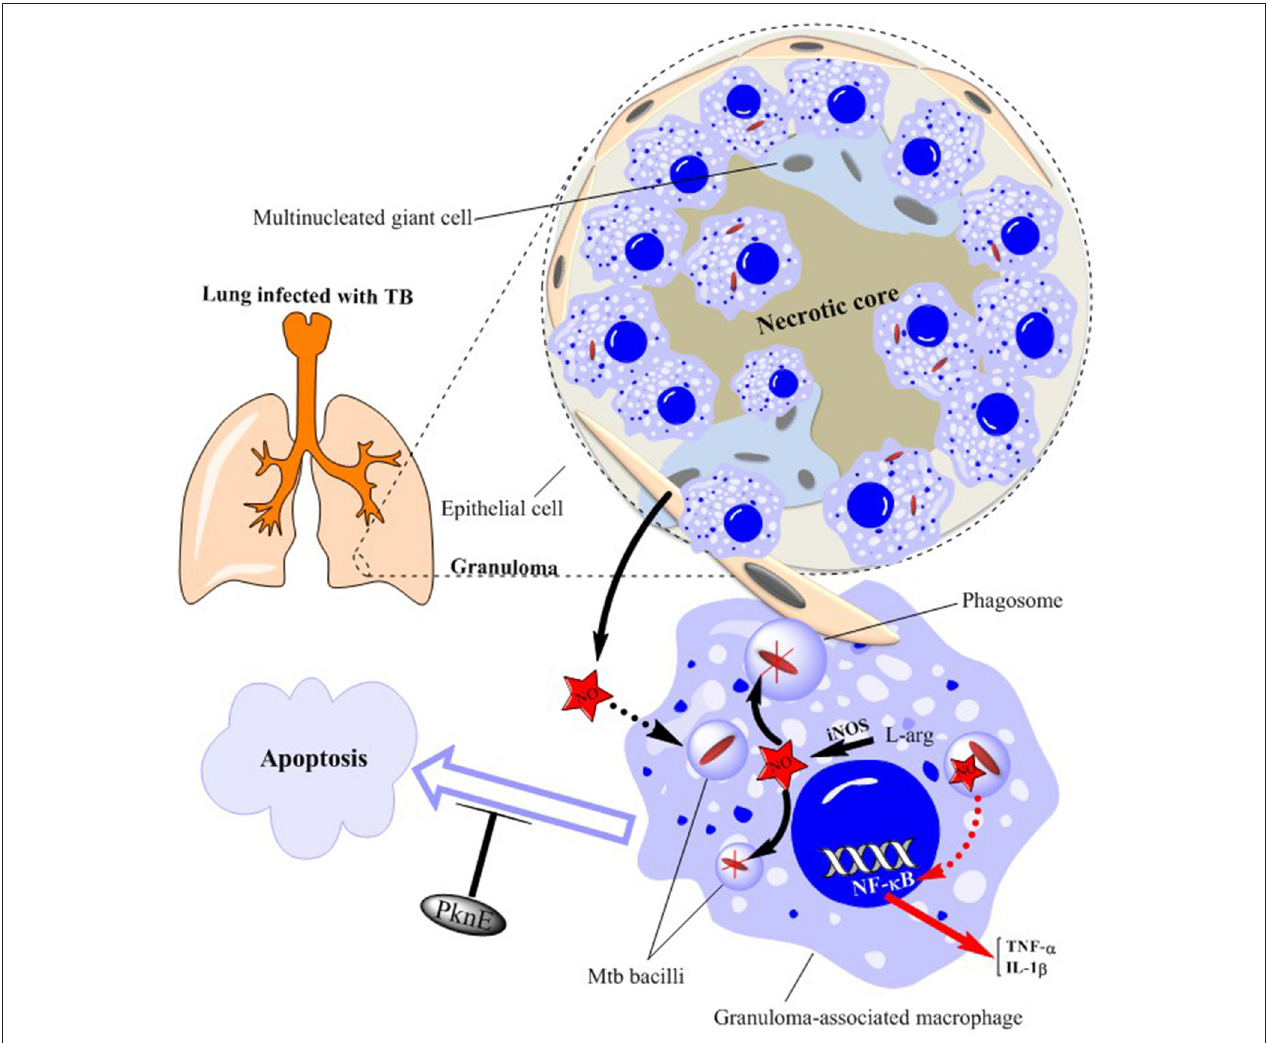
FIGURE 2 | Schematic illustration of granuloma components in a TB-infected lung. Mtb bacilli are ingested by macrophages within the lung. This produces a profound inflammatory and immune response which ultimately leads to the formation of granulomas consisting of epithelioid and multinucleated giant cells. Mtb bacilli within the granuloma-associated macrophages are killed by nitric oxide (NO) generated from inducible NO synthase (iNOS)—see expanded macrophage. NO production also stimulates NF- κ B activation leading to the production of inflammatory cytokines such as TNF α and IL-1 β . Epithelial cells surrounding the granuloma further support bacterial killing by producing more amounts of NO. Mtb infection results in inhibition of macrophage apoptosis as a means of increasing its survival which is prevented by altered levels of the serine/threonine protein kinase, PknE. NO, nitric oxide; PknE, Protein Kinase E; Mtb, Mycobacterium tuberculosis